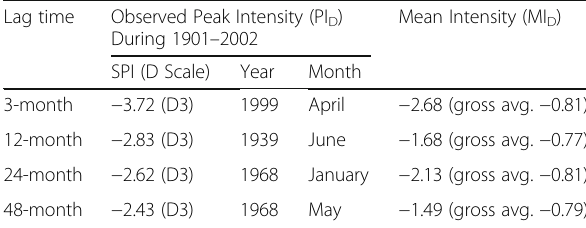
Table 3 Drought intensity at different time scale for GWB during 1901 –